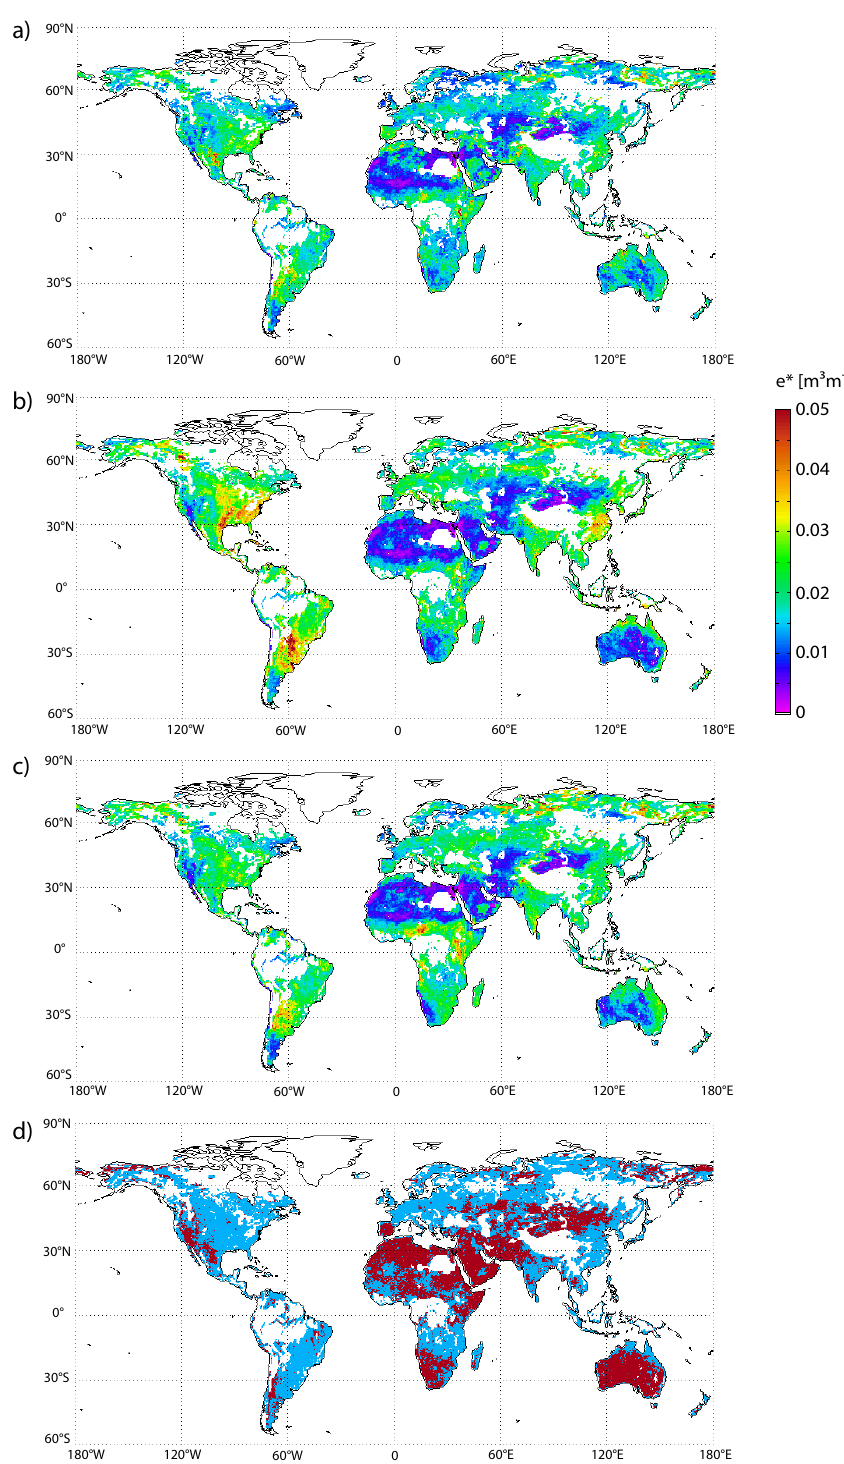
Fig. 1. Spatial errors of (a) ASCAT, (b) AMSR-E C-band, and (c) ERA-Interim surface soil moisture estimates. Errors are expressed in the climatology of ERA-Interim. (d) shows the areas in which either ASCAT (blue) or AMSR-E (red) shows the smallest error value. White areas indicate areas for which less than 100 common observations are